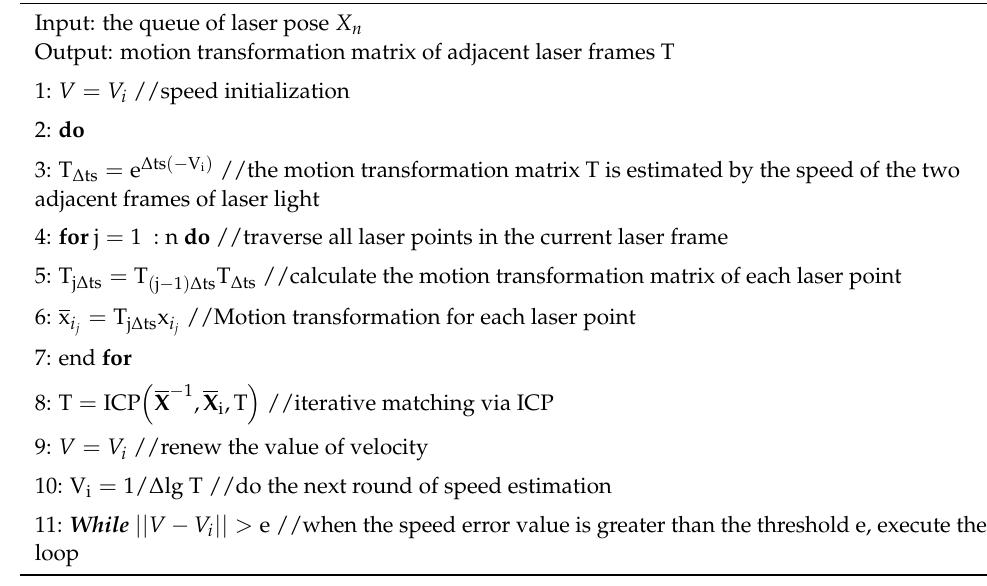
Algorithm 2: Estimating velocity and removing motion distortion from laser point cloud data